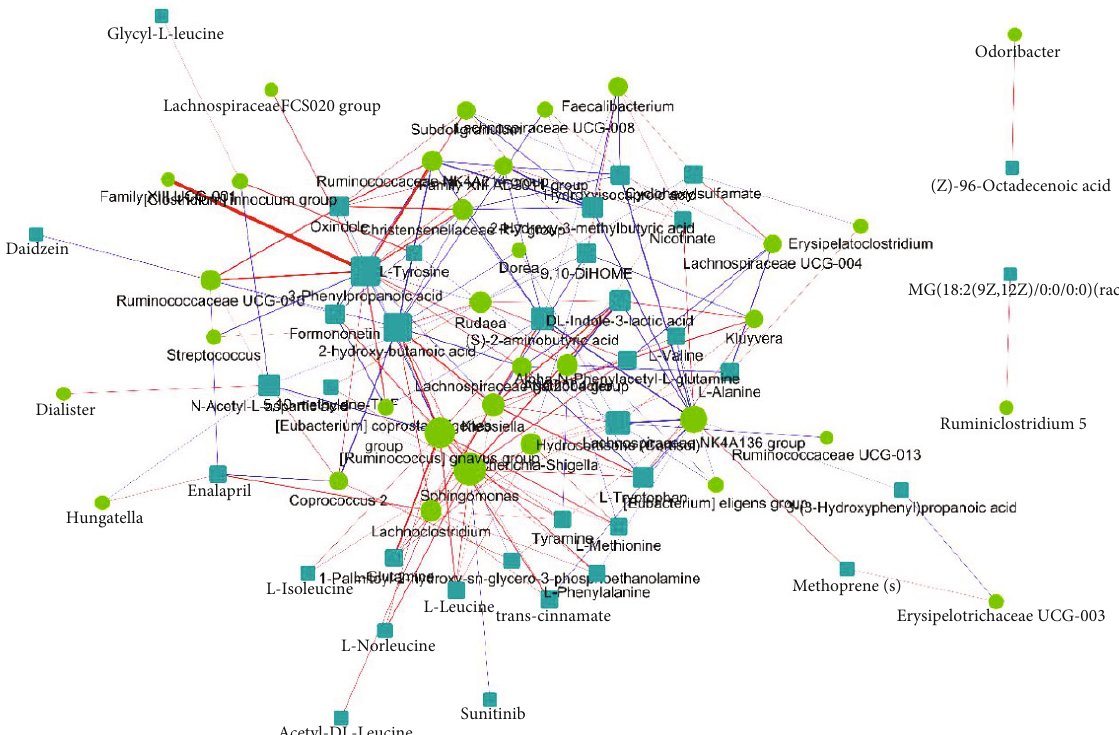
Figure 5: Circles represent signi fi cantly di ff erent genera, and rectangles represent signi fi cantly di ff erent metabolites. The color of the line represents the positive and negative value of correlation coe ffi cient (blue represents a negative correlation and red represents a positive correlation), and the thickness of the line is proportional to the absolute value of the correlation coe ffi cient. The node size is positively correlated with its degree (the greater the degree, the larger the node